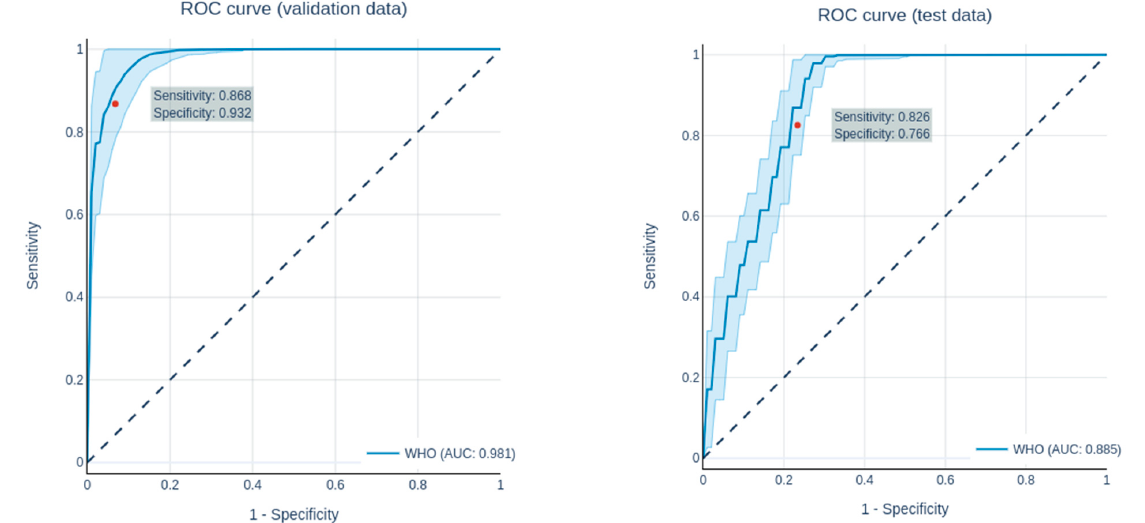
Figure 3. ROC curves of the prediction of the grading (LGG vs. HGG) in the validation data set ( left ) and the test data set (right ).